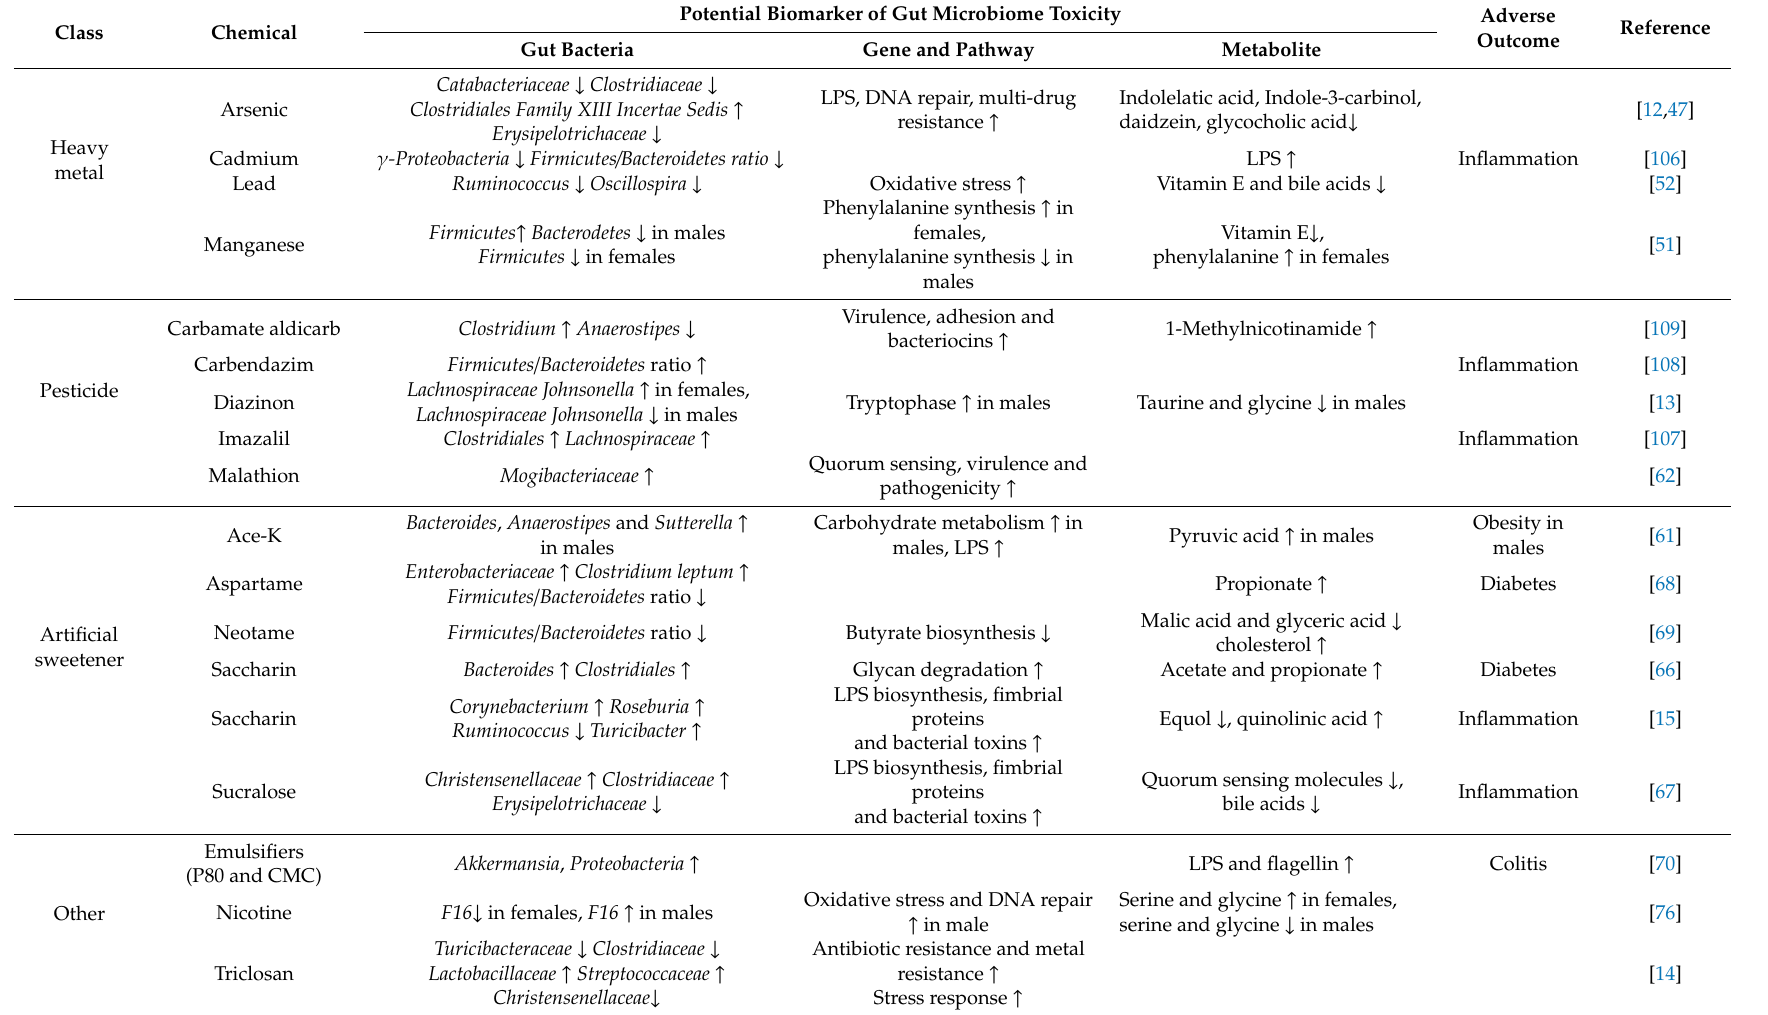
Table 1. Microbiome changes associated with specific chemical exposure that can serve as potential biomarkers of gut microbiome